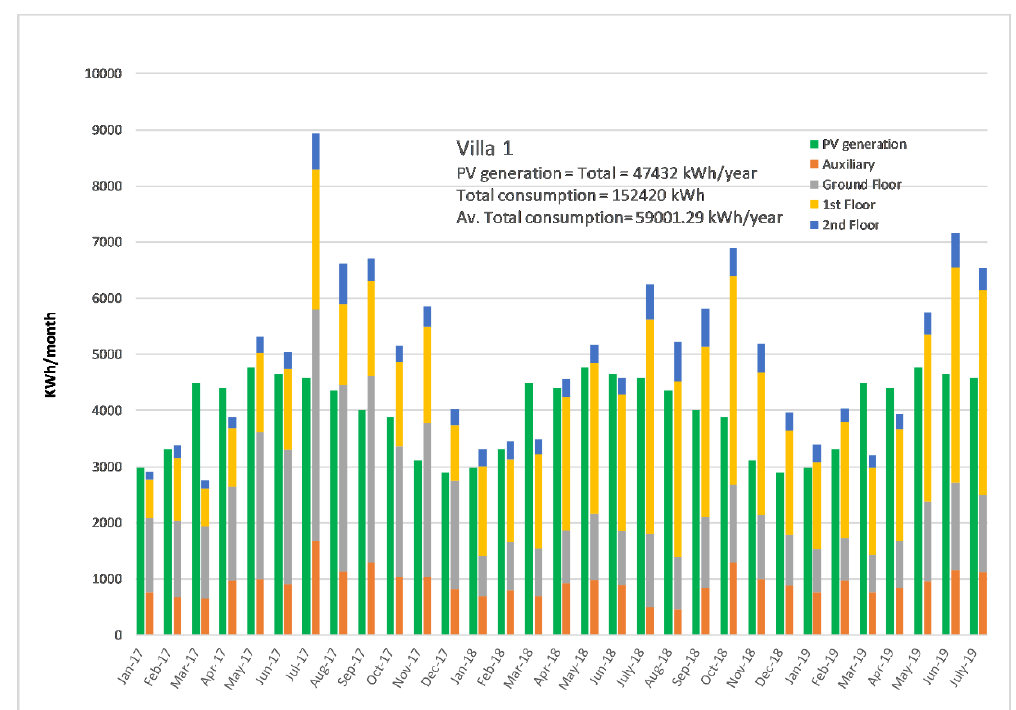
Figure 25. PV electricity generation vs consumption for Villa 1 for 30 months, from January 2017 until July 2019.